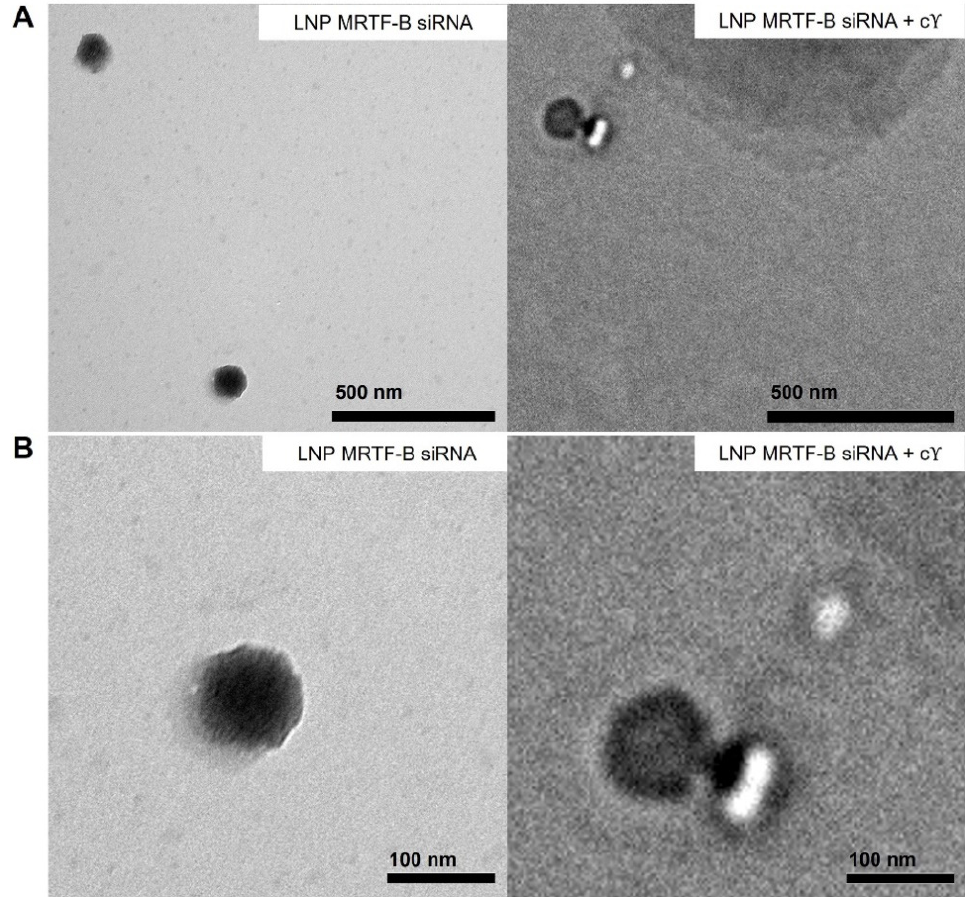
Figure 3. Negative staining transmission electron microscopy (TEM) images of LNP ‐ MRTF ‐ B siRNA and LNP ‐ MRTF ‐ B siRNA + c Υ . ( A ) Lower magnification. Scale bar, 500 nm. ( B ) Higher magnification. Scale bar, 100 nm.